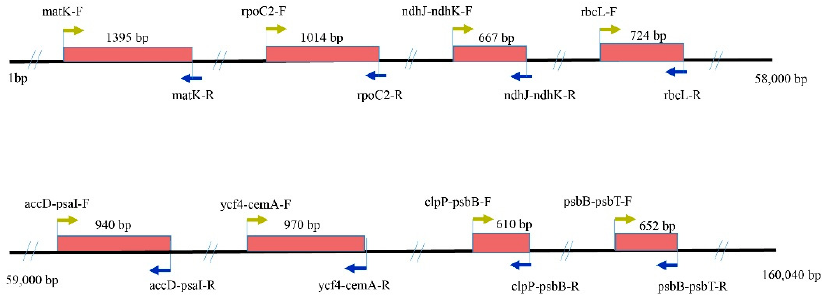
Figure 7. The relative positions of eight designed primers in two Coelogyne species. The arrow indicates the location and direction of the primer, which is amplified specifically. The rectangles in the red indicate the length of those products.